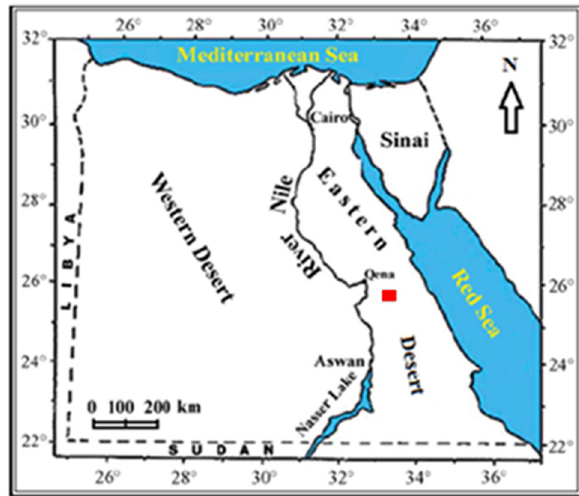
Fig. 1 Location map of the studied section, Eastern Desert, Egypt